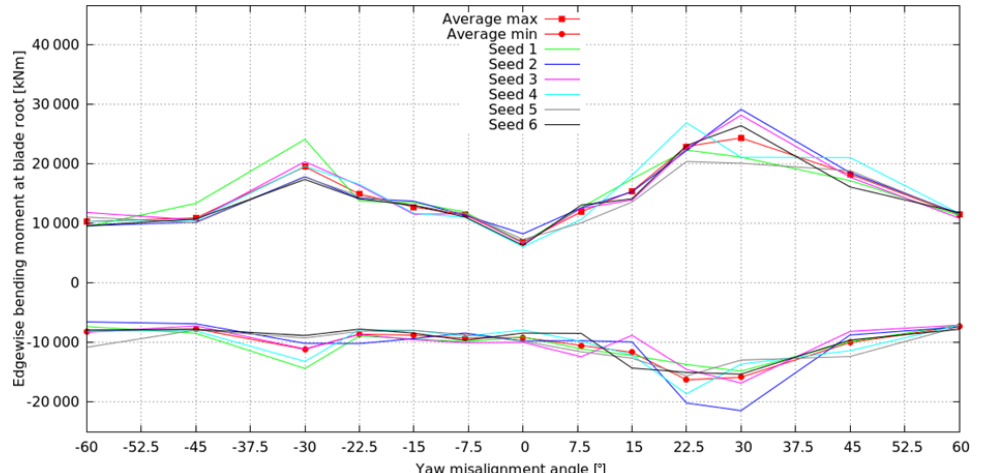
Figure 12. Ultimate blade root edgewise bending moments. Loads from six wind seeds are averaged. Wind speed 42.5ms − 1 ; TI = 11%; yaw angles in the range [ − 60 ◦ , + 60 ◦